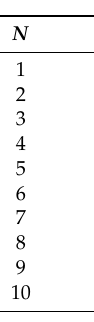
Table 4. Random Inconsistency Index